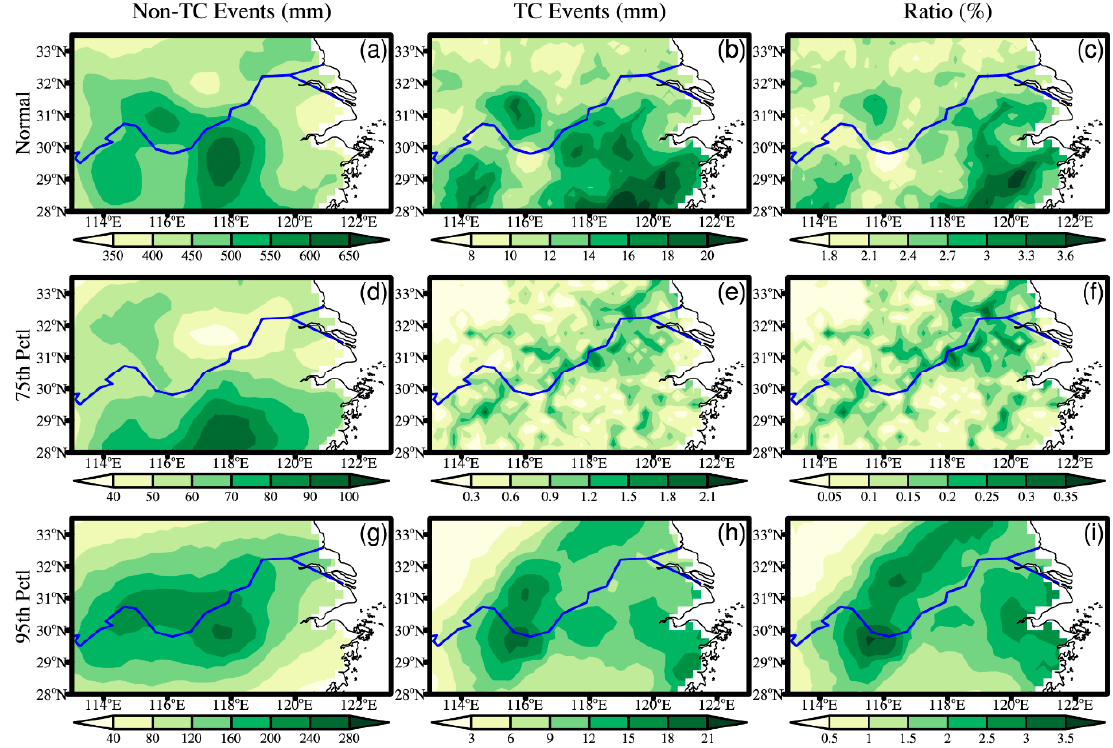
Figure 3. ( a – c ) Spatial distribution of the summer mean non-TC rainfall and TC-induced rainfall as well as relative contribution of TC-induced rainfall to the summer mean rainfall for normal precipitation events, respectively, shade denotes the rainfall amount and curve denotes the number of precipitation events. ( d – f ) The same as a–c, but for 75th percentile precipitation events. ( g – i ) The same as ( a – c ), but for 95th percentile precipitation events. The bold blue curve denotes the Yangtze River.